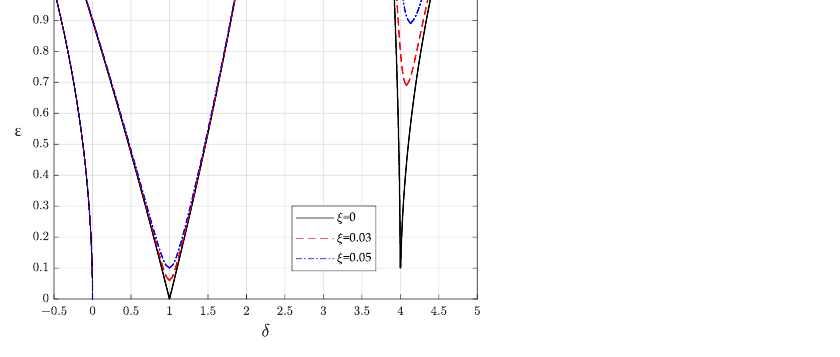
Figure 9. Stability chart of Mathieu equation: